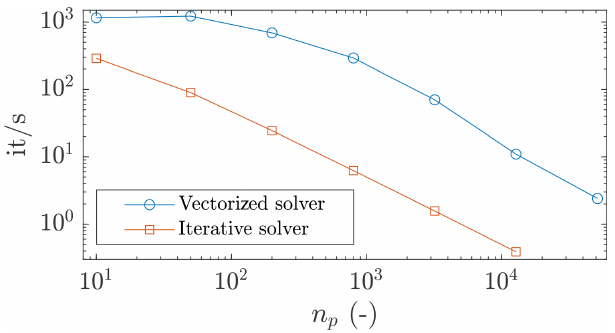
Figure 19. Number of iterations per second with respect to the to- tal number of material points n p . The greatest performance gain is reached around n p = 1000, which is related to the peak perfor- mance of the solver (see Fig. 18). The gains corresponding to the peak performance and residual performance are 46 and 28 respec-